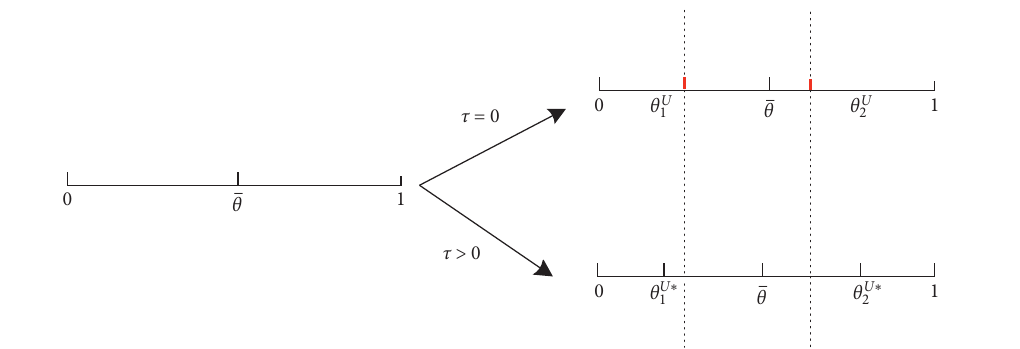
Figure 6: The location of marginal consumers (no extensions vs. upward extension).